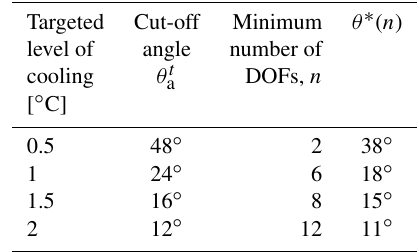
Table 2. The minimum number of DOFs, n , of the SAI design space for four targeted levels of cooling. At each level of cooling, θ t a is the maximum angle that can be formed between two AOD patterns that yield undetectably different temperature responses. θ ∗ ( n ) is the maximum angle that can be formed between any AOD pattern and the design space of n DOFs and must be smaller than θ t a .